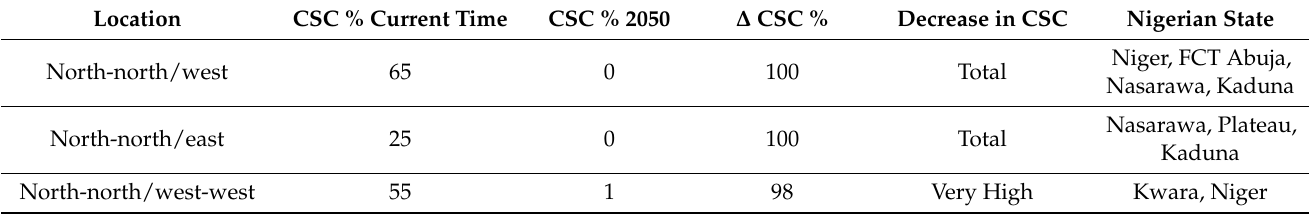
Table 1. Combined suitable climates (CSC) for growing OP in each orientation and associated Nigerian states. The states in bold are present in more than one location and the states with moderate or high palm oil production are indicated in